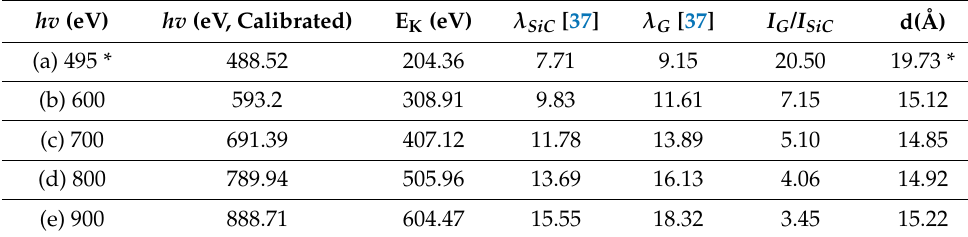
Table 1. Thickness estimation with the fitting result from Figure 4. hv